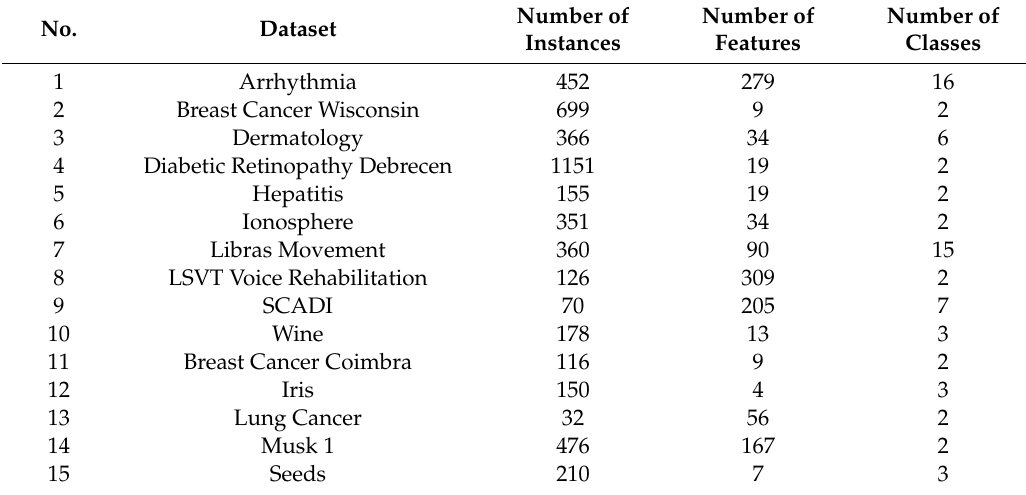
Table 1. List of the used